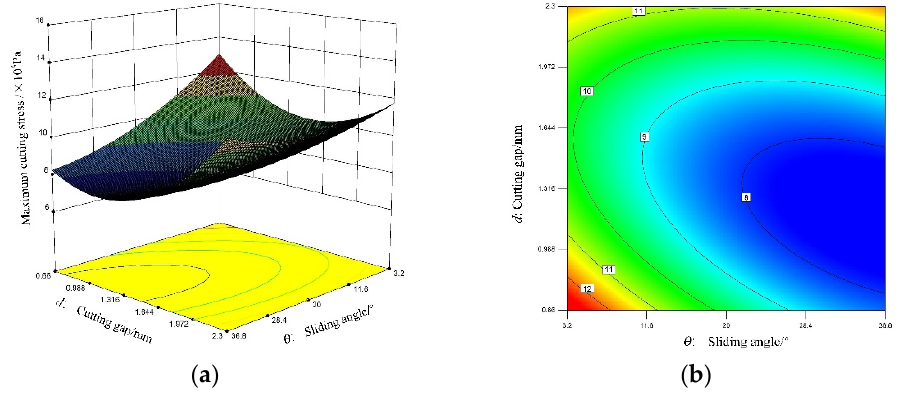
Figure 6. Effects of the sliding cutting angle and cutting gap on maximum cutting stress. ( a ) Response surface graph. ( b ) Contour